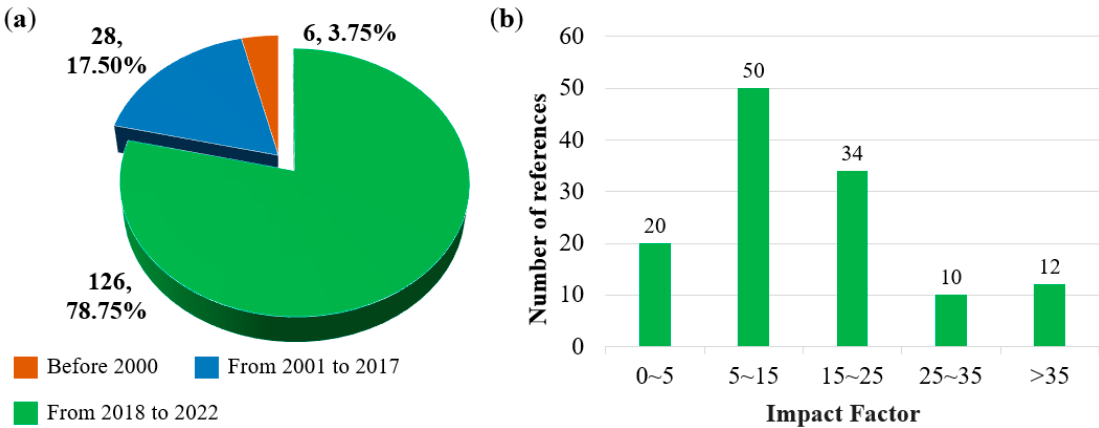
Figure 2. Analysis of references: ( a ) Classified by year; ( b ) Impact factor in last five years.